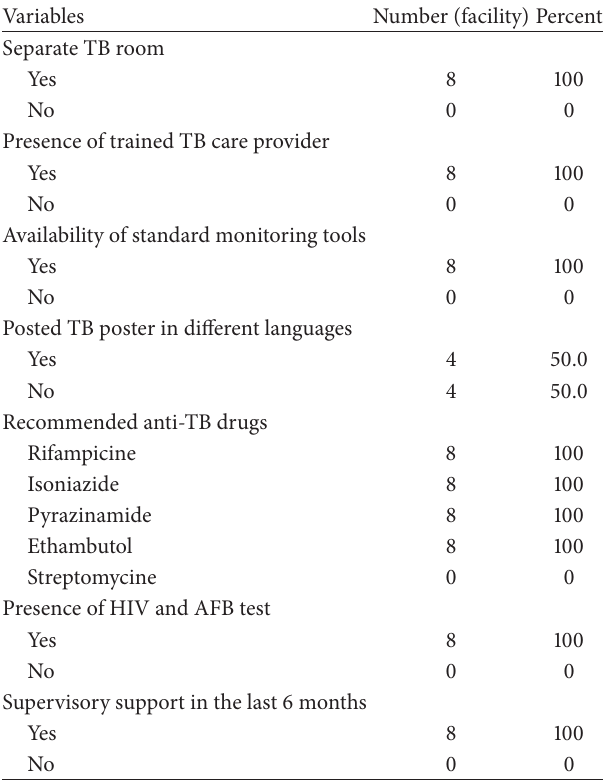
Table 2: Summary of selected structure indicators in private health facilities of A. A,